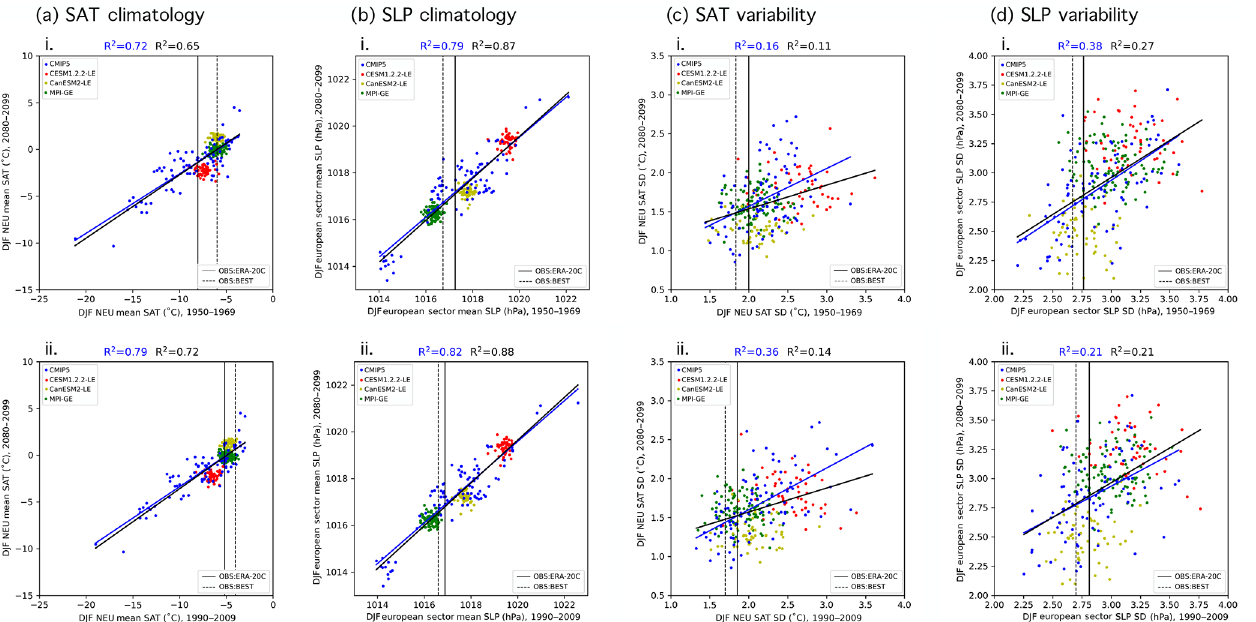
Figure C1. Predictor relationships in DJF comparing domain-averaged climate in two historical periods, (i) 1950–1969 and (ii) 1990–2009, to a future period, 2080–2099, in all panels. Observational estimates in the respective historical periods are indicated with a solid vertical line (ERA-20C SAT and SLP) and dashed vertical black line (BEST SAT and NOAA-20C SLP) in each panel. (a) NEU SAT climatology ( ◦ C), (b) SLP climatology averaged over the predictor region (hPa), (c) NEU SAT standard deviation ( ◦ C), and (d) SLP standard deviation averaged over the predictor region (hPa), each aggregated over the two historical periods, are eight of the nine predictors used to determine RMSE member performance and independence in Fig. 3. Least-squares regression fits (solid lines) and R 2 values computed solely for the CMIP5 output are shown in blue, and those computed for all output (CMIP5 and the three SMILEs) are shown in black.